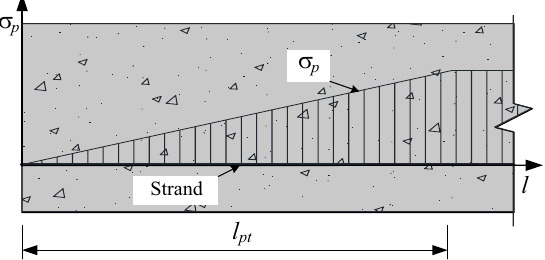
Fig. 3. Prestressing strand stress profile along the transfer length after release